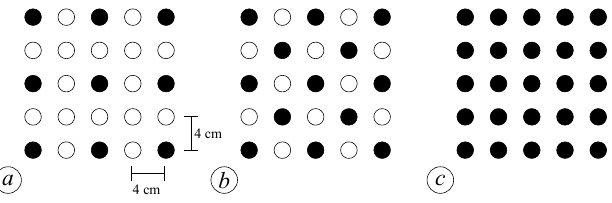
Figure 2. Vegetation patterns for the three tested configurations: ( a ) plant density n = 156.25 cylinder/m 2 ;